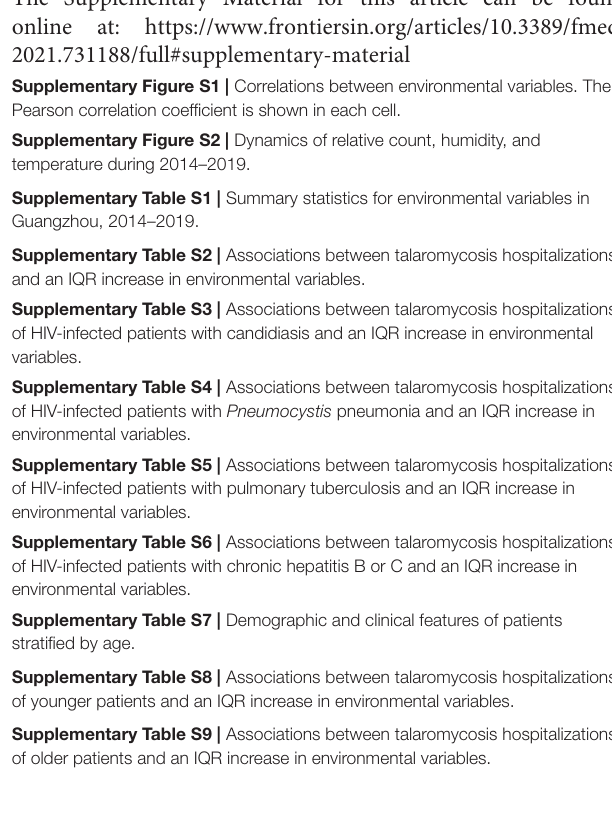
Supplementary Figure S1 | Correlations between environmental variables. The Pearson correlation coefficient is shown in each cell. Supplementary Figure S2 | Dynamics of relative count, humidity, and temperature during 2014–2019. Supplementary Table S1 | Summary statistics for environmental variables in Guangzhou, 2014–2019.